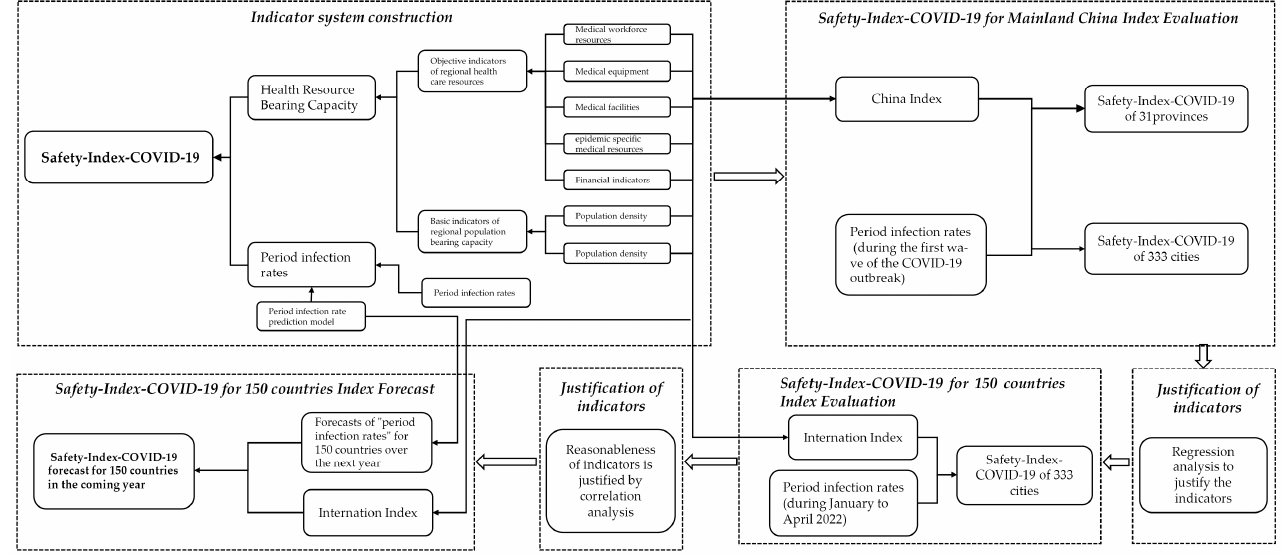
Figure 1. Research framework.